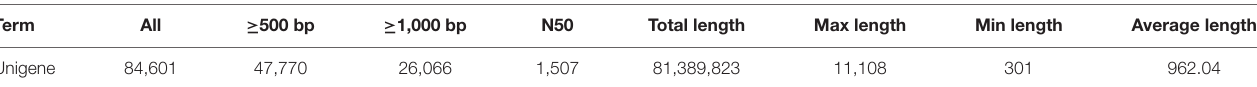
TABLE 3 | Transcriptome assembly